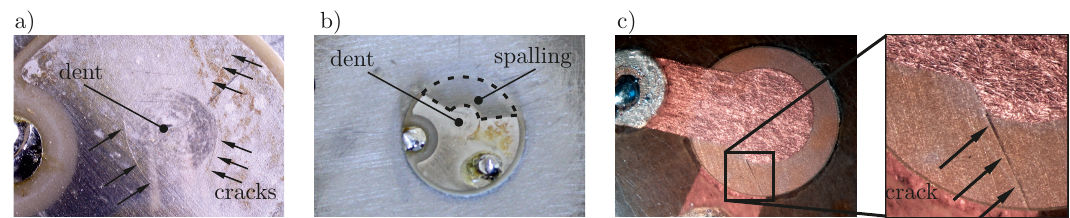
Figure 1. Types of Breakage: ( a ) Simple disc-shaped transducer (PIC 255, PI Ceramic GmbH, Lederhose, Germany) with cracks; ( b ) Simple disc-shaped transducer (PIC 255) with cracks and spalling, i.e., breakage into different pieces; ( c ) Embedded transducer (DuraAct, [34]) with